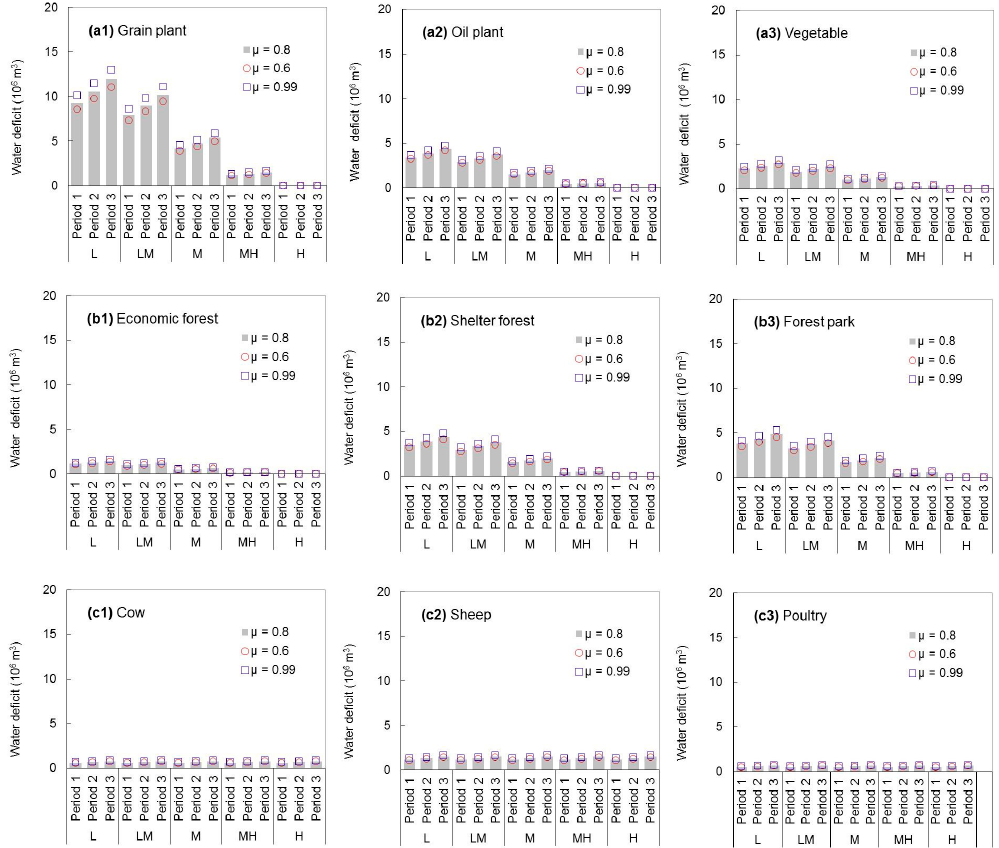
Figure 3. Water deficits without ecological effect under case 1 when µ are 0.6, 0.8, and 0.99.